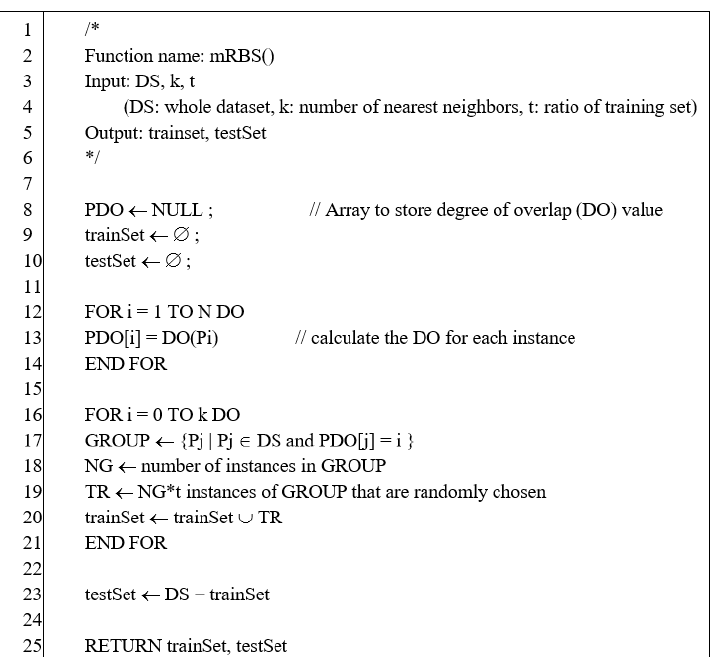
Figure 4. Pseudocode of modified R-value-based sampling (RBS).